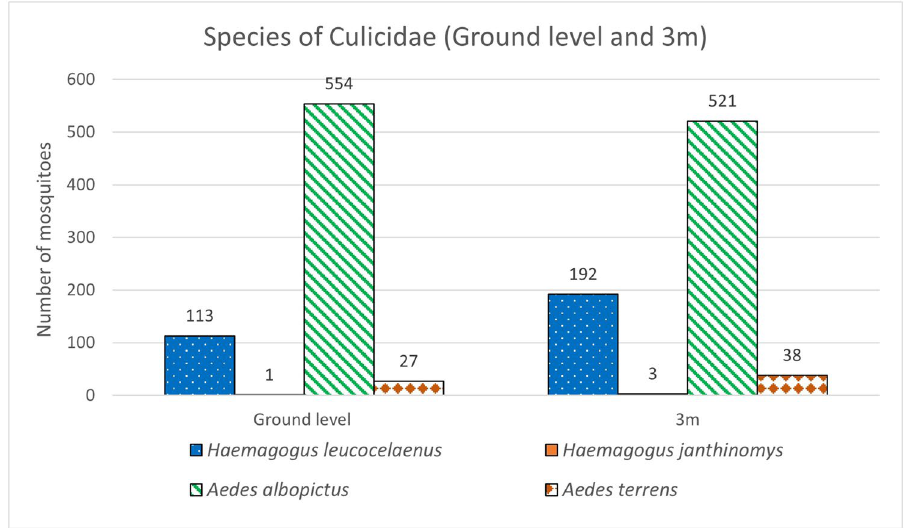
Figure 1. Species of Culicidae collected at ground level and 3 m, in Córrego da Luz Municipal Park, in the city of Casimiro de Abreu, Rio de Janeiro state,